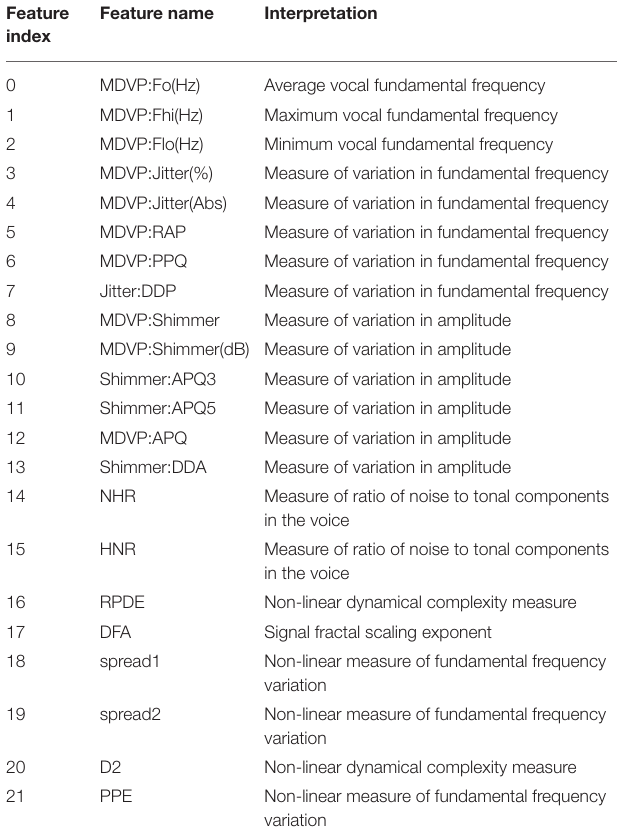
TABLE 1 | Feature explanation of Speech Data Set (Little et al., 2007; Par, 2007).